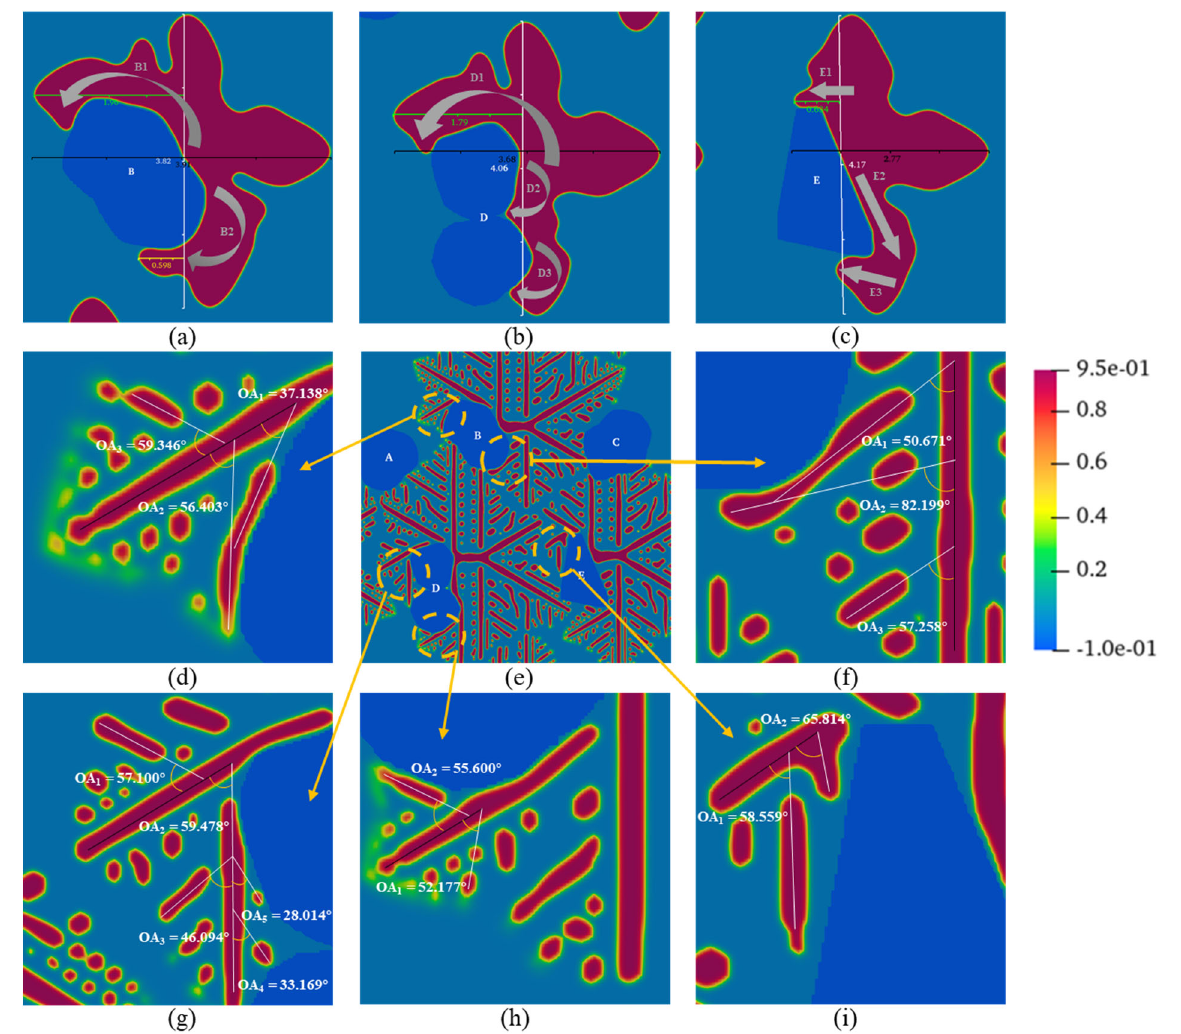
Figure 7. Details of PTFE crystal morphology at the biphasic interface of different fillers. ( a – c ) Details of Figure 6c; ( e ) morphology evolution diagram of a PTFE crystal with a rodlike nucleus shape with second ‐ phase filler (evolution time τ = 180); ( d , f – i ) details of ( e ).